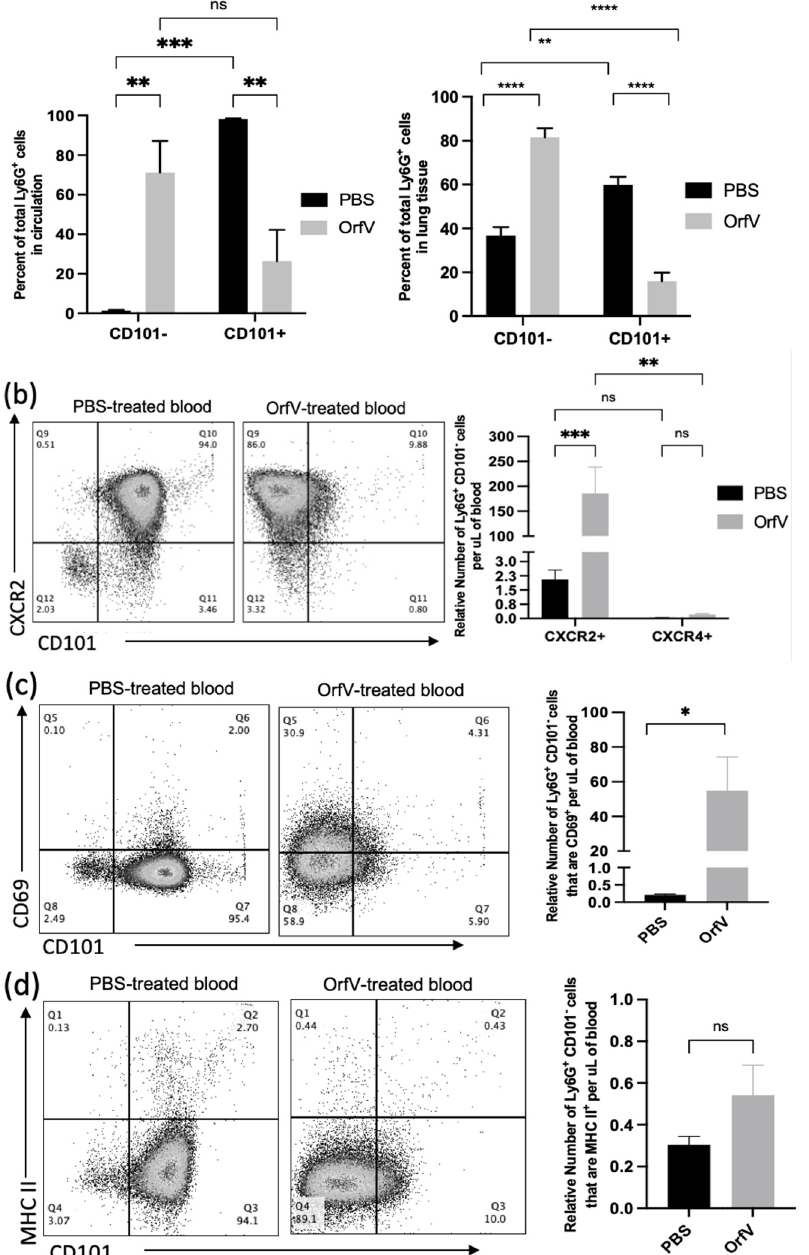
Figure 2. Immature neutrophils with increased surface expression of migratory and activation molecules entered circulation and colonized the TME of the lungs following OrfV therapy. Twenty-four hours after treatment with OrfV or PBS, blood, and lungs from pulmonary B16F10 metastasis-bearing seven- to nine-week-old female C57BL/6 mice were collected ( n = 8 per group), and neutrophils were quantified with flow cytometry. Representative dot plots and graphs with standard errors are shown for ( a ) neutrophils (defined as CD45 + Ly6G hi CD11b hi ), and their corresponding maturity status (defined by expression of CD101); ( b ) phenotypically immature (CD101 - ) neutrophils expressing the lung-homing chemokine receptor CXCR2 in circulation; ( c ) activation status of circulating immature neutrophils (defined by expression of CD69 and CD101); ( d ) immature neutrophils expressing the antigen presentation molecule major histocompatibility complex class II (MHC II). Statistical analysis was performed using two-way analysis of variance in the case of ( a , b ) and by a two-tailed Student’s t -test for ( c , d ). Statistical significance was designated as * p ≤ 0.05, ** p ≤ 0.01, *** p ≤ 0.001, and **** p ≤ 0.0001.